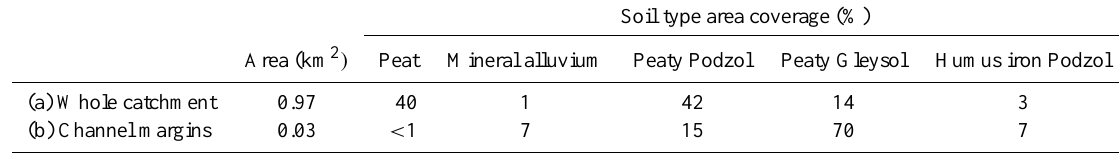
Table 1. Soil types in (a) the whole catchment and (b) channel margins (defined as 10m strips adjacent to the stream channel). Soil type area coverage (%) Area (km 2 ) Peat Mineral alluvium Peaty Podzol Peaty Gleysol Humus iron Podzol